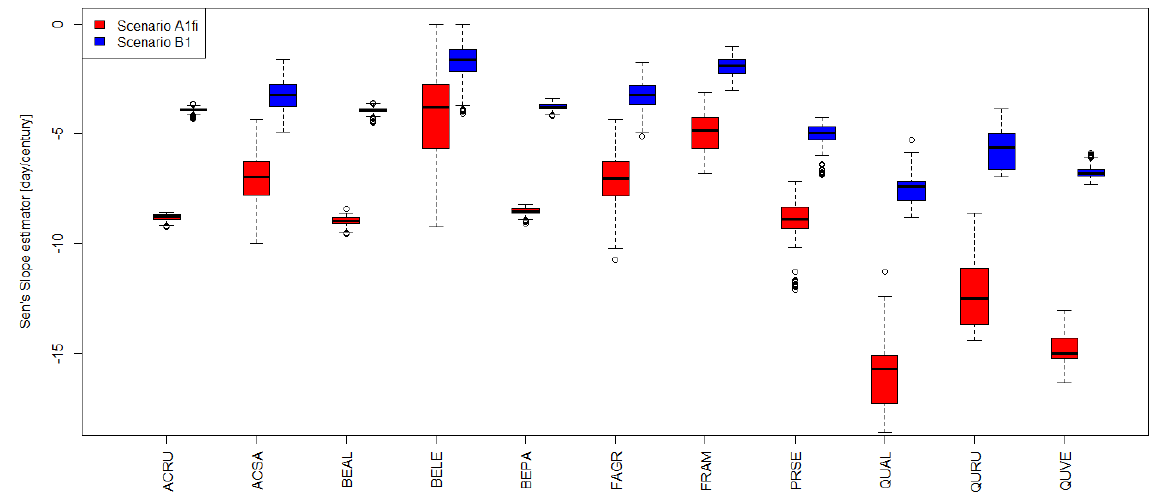
Fig. 5. Violin-plot of the trends computed with the Sen’s slope estimator for each species. Bud-burst dates (BB) projections were modeled by using the best model selected and the parameters ensemble (1000 parameter set) for each species (Table 1). The white circles represent the mean of the distribution. Red violins represent the predictions under the Scenario A1fi, while blue violins represent the predictions under the Scenario B1.